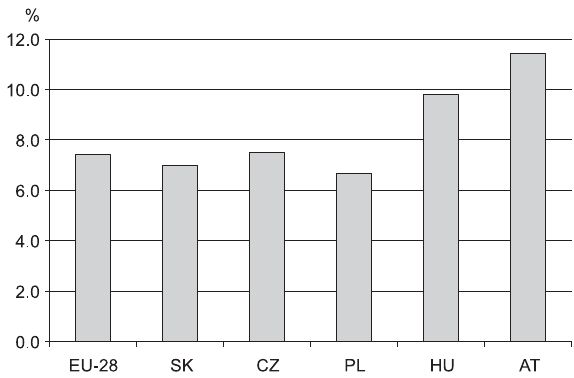
Fig. 5. Share of railways in the modal split of passenger transport on land in selected countries in 2012 (pkm in %).